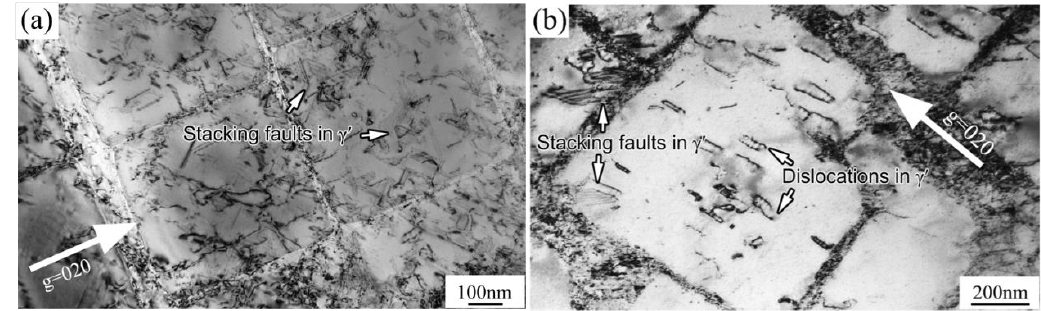
Figure 4. TEM images of deformation microstructures at low temperatures: ( a ) RT; ( b ) 600 °C.